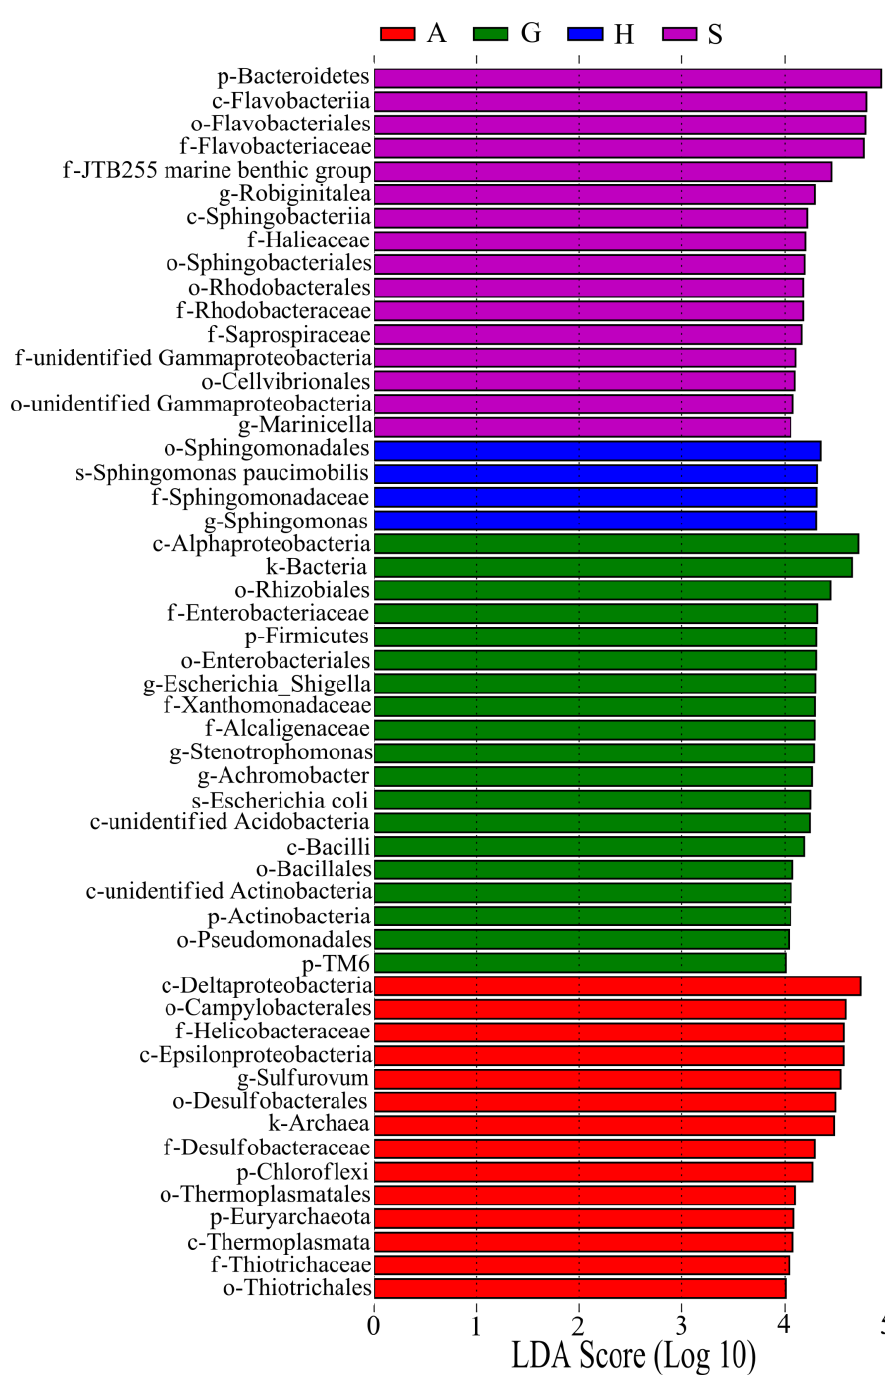
Figure 5. Microbial taxa with different abundances in the worm intestine and different sediments identified by LEfSe using an LDA score threshold of >4.0. s, Species; g — genus; f — family; o — order; c — class; p — phylum. S — surface sediment; H — sediment in the hole; A — ambient sediment; G — gut of S. nudus .